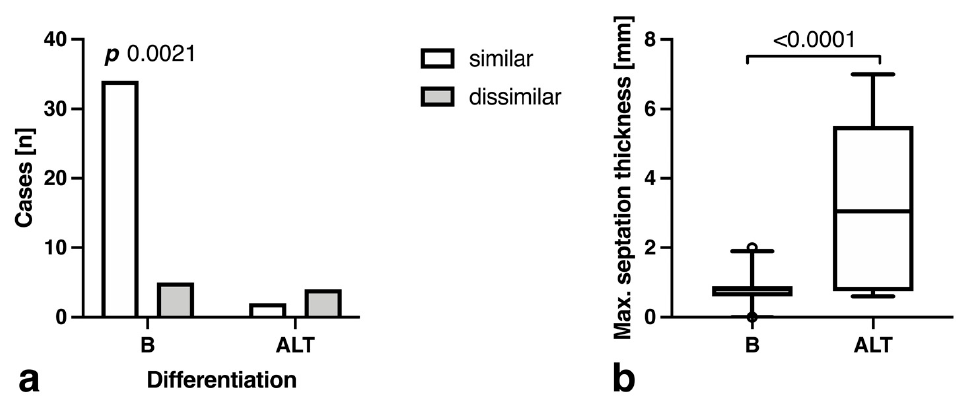
Figure 3. Bar plots demonstrating ( a ) septation morphology compared to surrounding fatty tissue and ( b ) maximum septation thickness in benign (B) tumors and atypical lipomatous tumors (ALT). Outliers are depicted as circles.